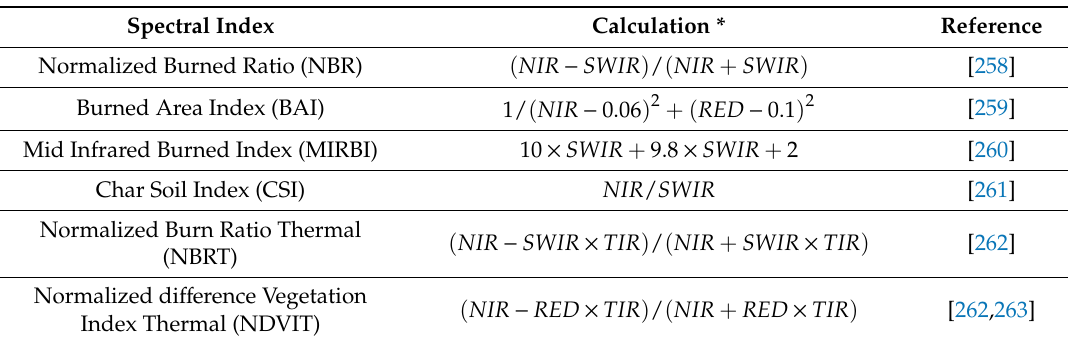
Table 7. Non-exhaustive list of spectral remote sensing indexes developed to discriminate fire from optical satellite image analysis and that can be useful within the frame of animal movement studies in savanna